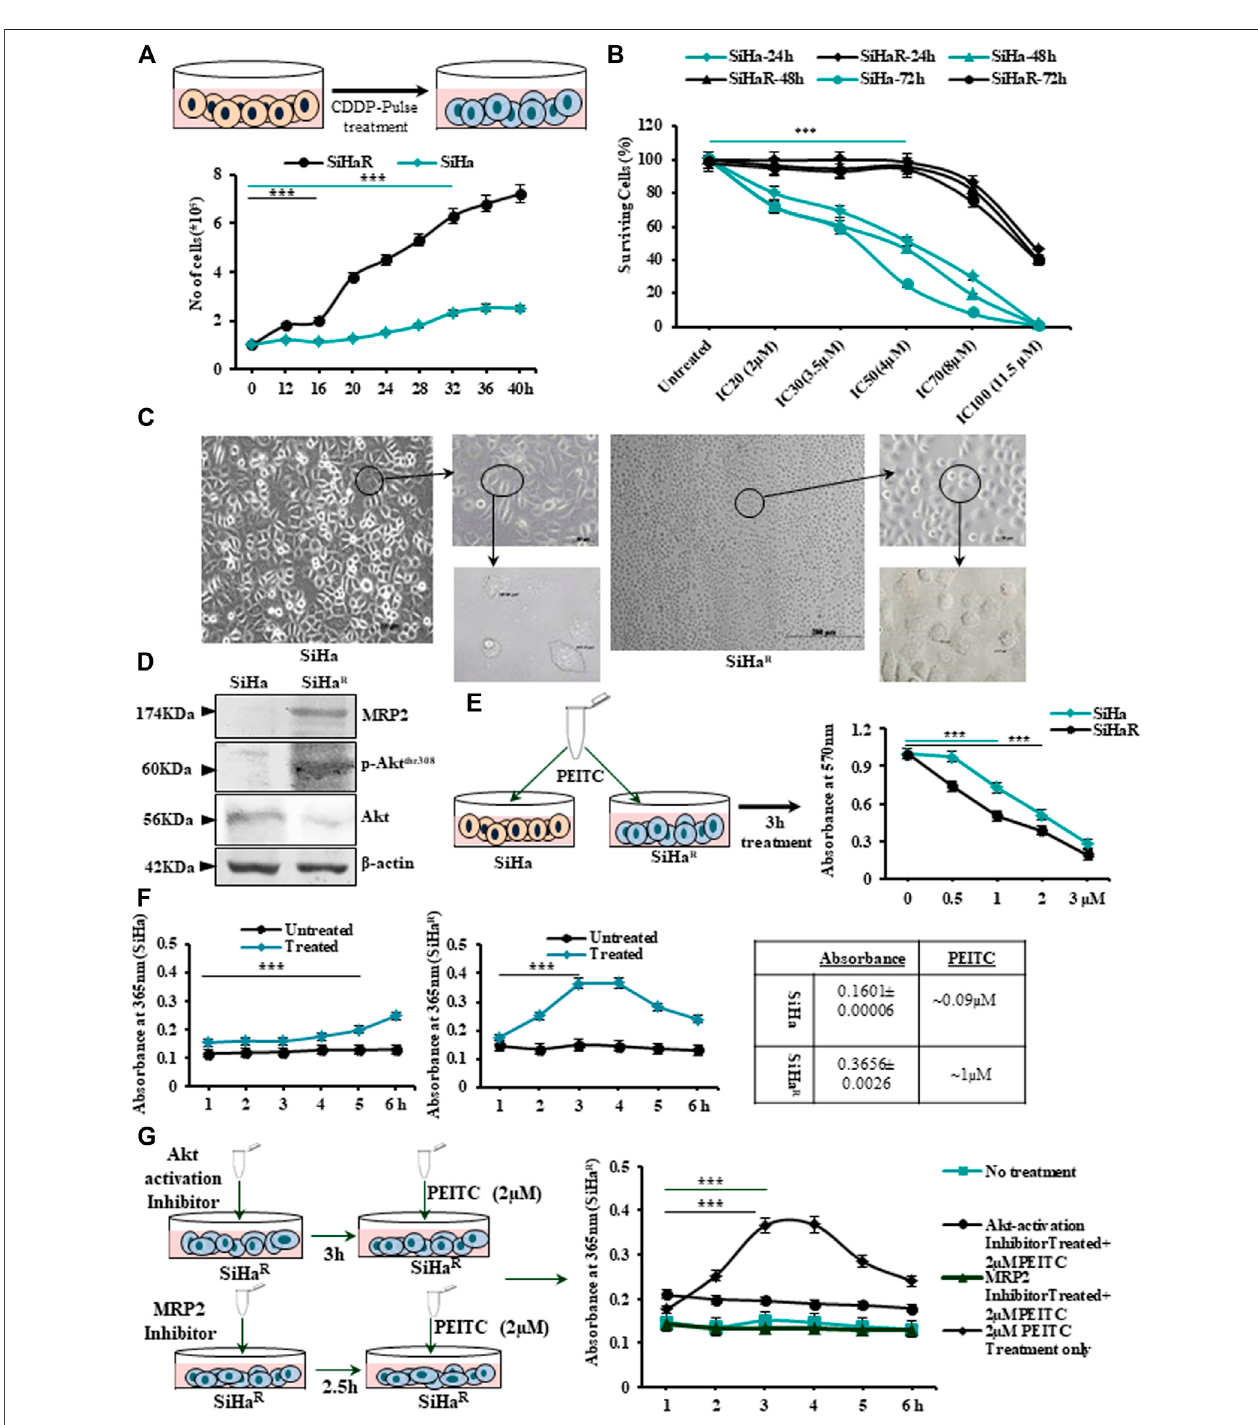
FIGURE 1 | (A) Schematic outline of the “ pulse treatment ” methodology followed for the development of cisplatin (CDDP)-resistant subline SiHa R from the parental CDDP-sensitive SiHa cell line (upper panel). Representation of the cell-growth patterns depicting differences in the doubling time (SiHa-32h and SiHa R - 16 h) in agraphicalformat(lower panel). (B) GraphicalanecdoteoftheMTT survivability assay results for SiHaand SiHa R cells followingtreatmentwith CDDPfor 24, 48, and 72 h with IC 20 (2 µM), IC 30 (3.5 µM), IC 50 (4 µM), IC 70 (8 µM), and IC 100 (11.5 µM) CDDP doses of SiHa at 24 h. (C) Phase-contrast micrographic snippets of SiHa and SiHa R representing remarkable differences in their morphology. Magni fi cation for the main image is ×100 (Scale bar: 100 µm), while that of the subsequent insets are 200x (Scale bar: 50 µm) and ×400 (Scale bar: 20 µm). (D) Western blot results depicting differential expression patterns of Akt, p-Akt Thr308 , and MRP2 proteins in SiHa and SiHa R . Respective band intensities as calculated by ImageJ software have been provided in Supplementary Data S2 . (E) Pictorial demonstration of the experiment and the subsequent graphical representation of MTT assay results for identifying the respective IC 50 doses of